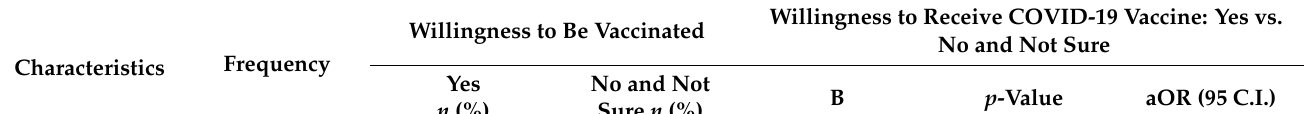
Figure 2. Bar graph representing the various reasons for not willing (No and Not sure) to receive COVID-19 vaccine among the Indonesian study participants. Total number of responses: 1707. 3.4. Awareness, Risk Perception, Impact of COVID-19 and Flu Vaccination History Almost all the participants (3411/3426; 99.6%) were aware of the COVID-19 cases in Indonesia, but only 89.8% participants (3071/3419) were well informed about the Phase III COVID-19 vaccine trial in Indonesia [Table 3]. More than two-thirds of the participants (2361/3415; 69.1%) believed that they were at risk of contracting COVID-19. Less than 4% (128/3418) of the participants stated that they had already been infected with SARS-CoV-2. However, 737 (22.1%) participants had family members who were infected with SARS- CoV-2. Almost half (1538/3344; 46%) of the participants knew friends who had contracted SARS-CoV-2. It was also observed that the uptake of the Influenza vaccine among the participants was low in Indonesia, with 7.7% (263/3411) of the study participants having received a flu vaccine in the past five years [Table 3]. Table 3. Multivariate logistic regression analysis of different factors with respect to (w.r.t.) willingness to be vaccinated.